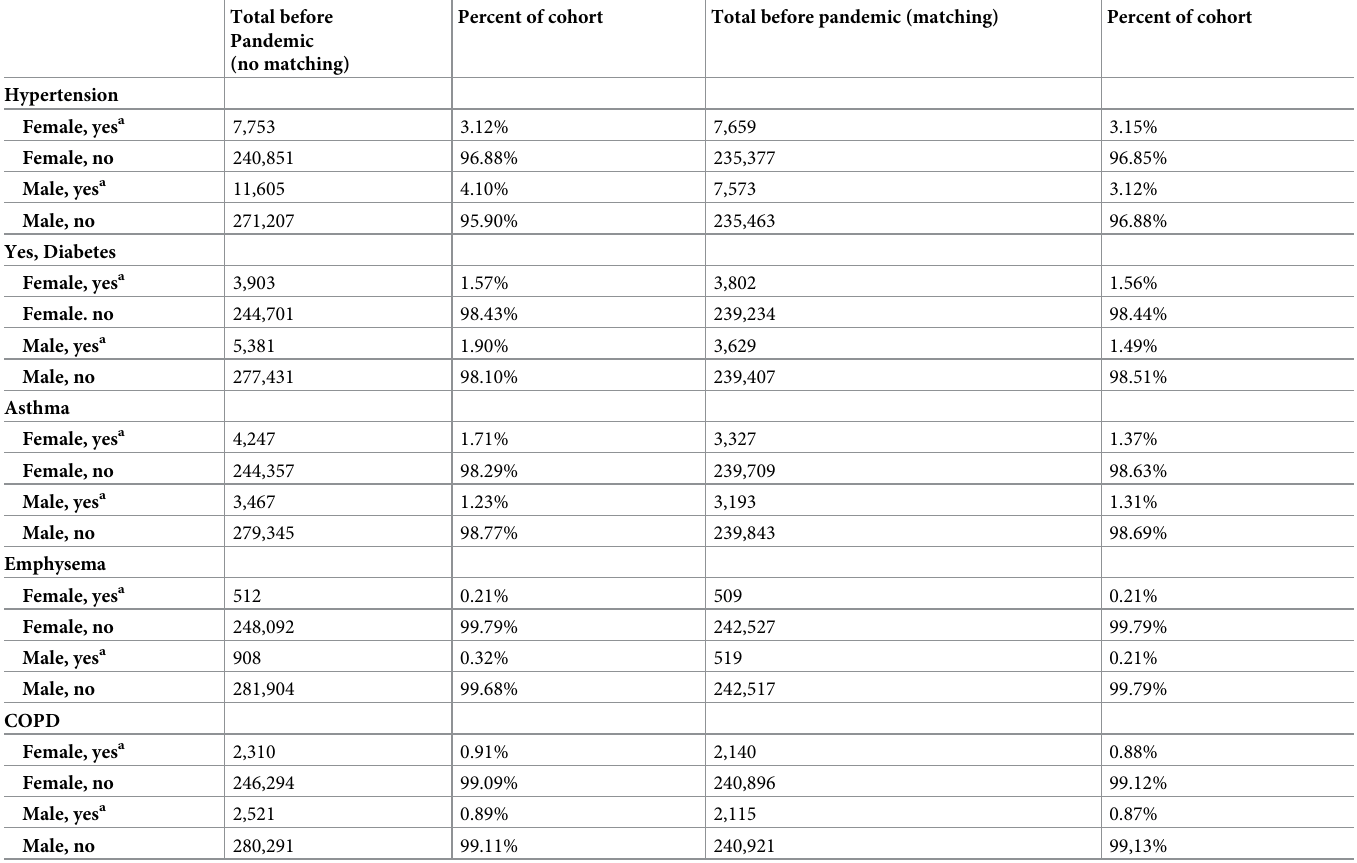
Table 1. Creating the matched cohorts.